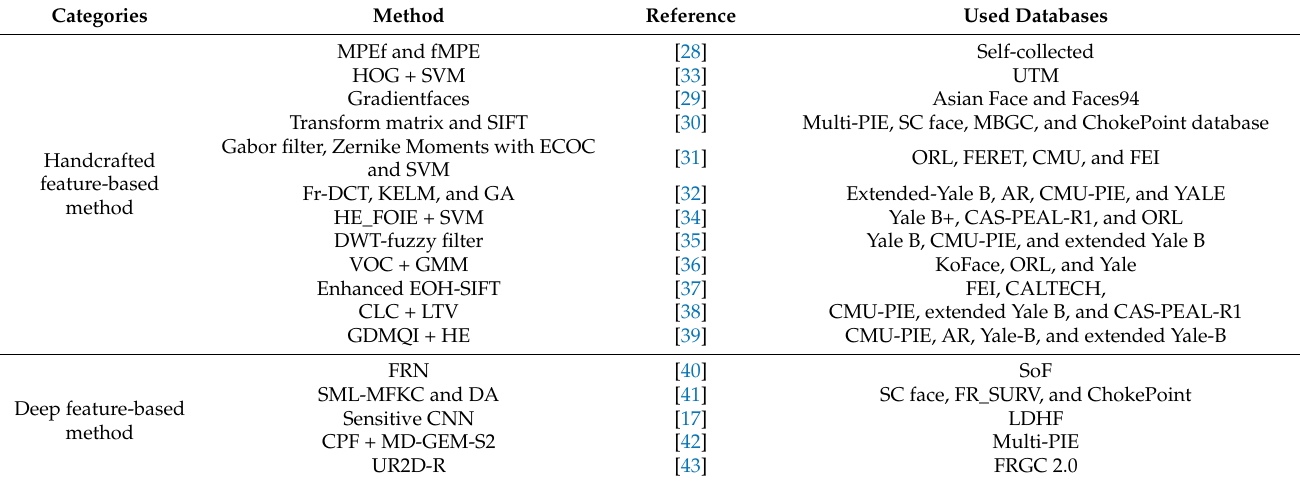
Table 3. Studies on face recognition robust to low illumination. All the methods except for [10,17] used open